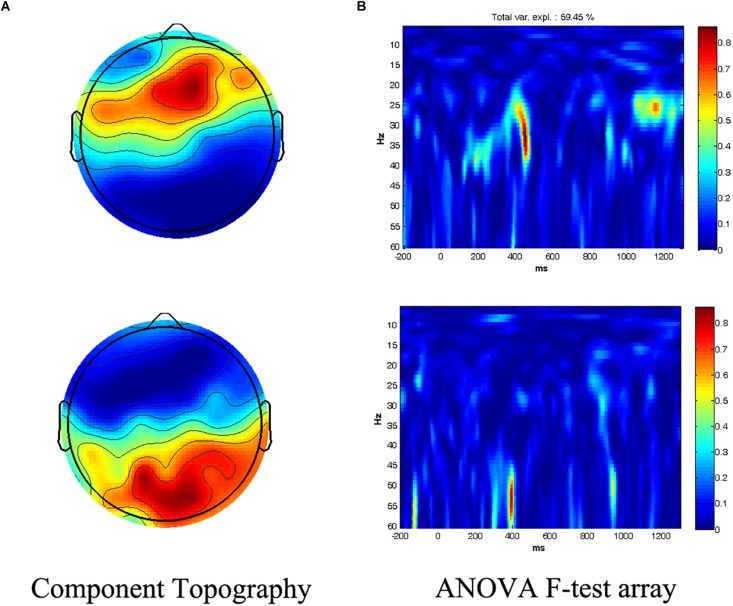
Differences between the radical and stroke chunking condition, as obtained through the parallel-factor analysis (PARAFAC) model. (A) Topography of the resulting 2 components, which show the largest difference during the chunking processes with frontal and occipito-parietal peaks, respectively. (B) Spectral and temporal characteristics of each component are displayed with their relative intensity.